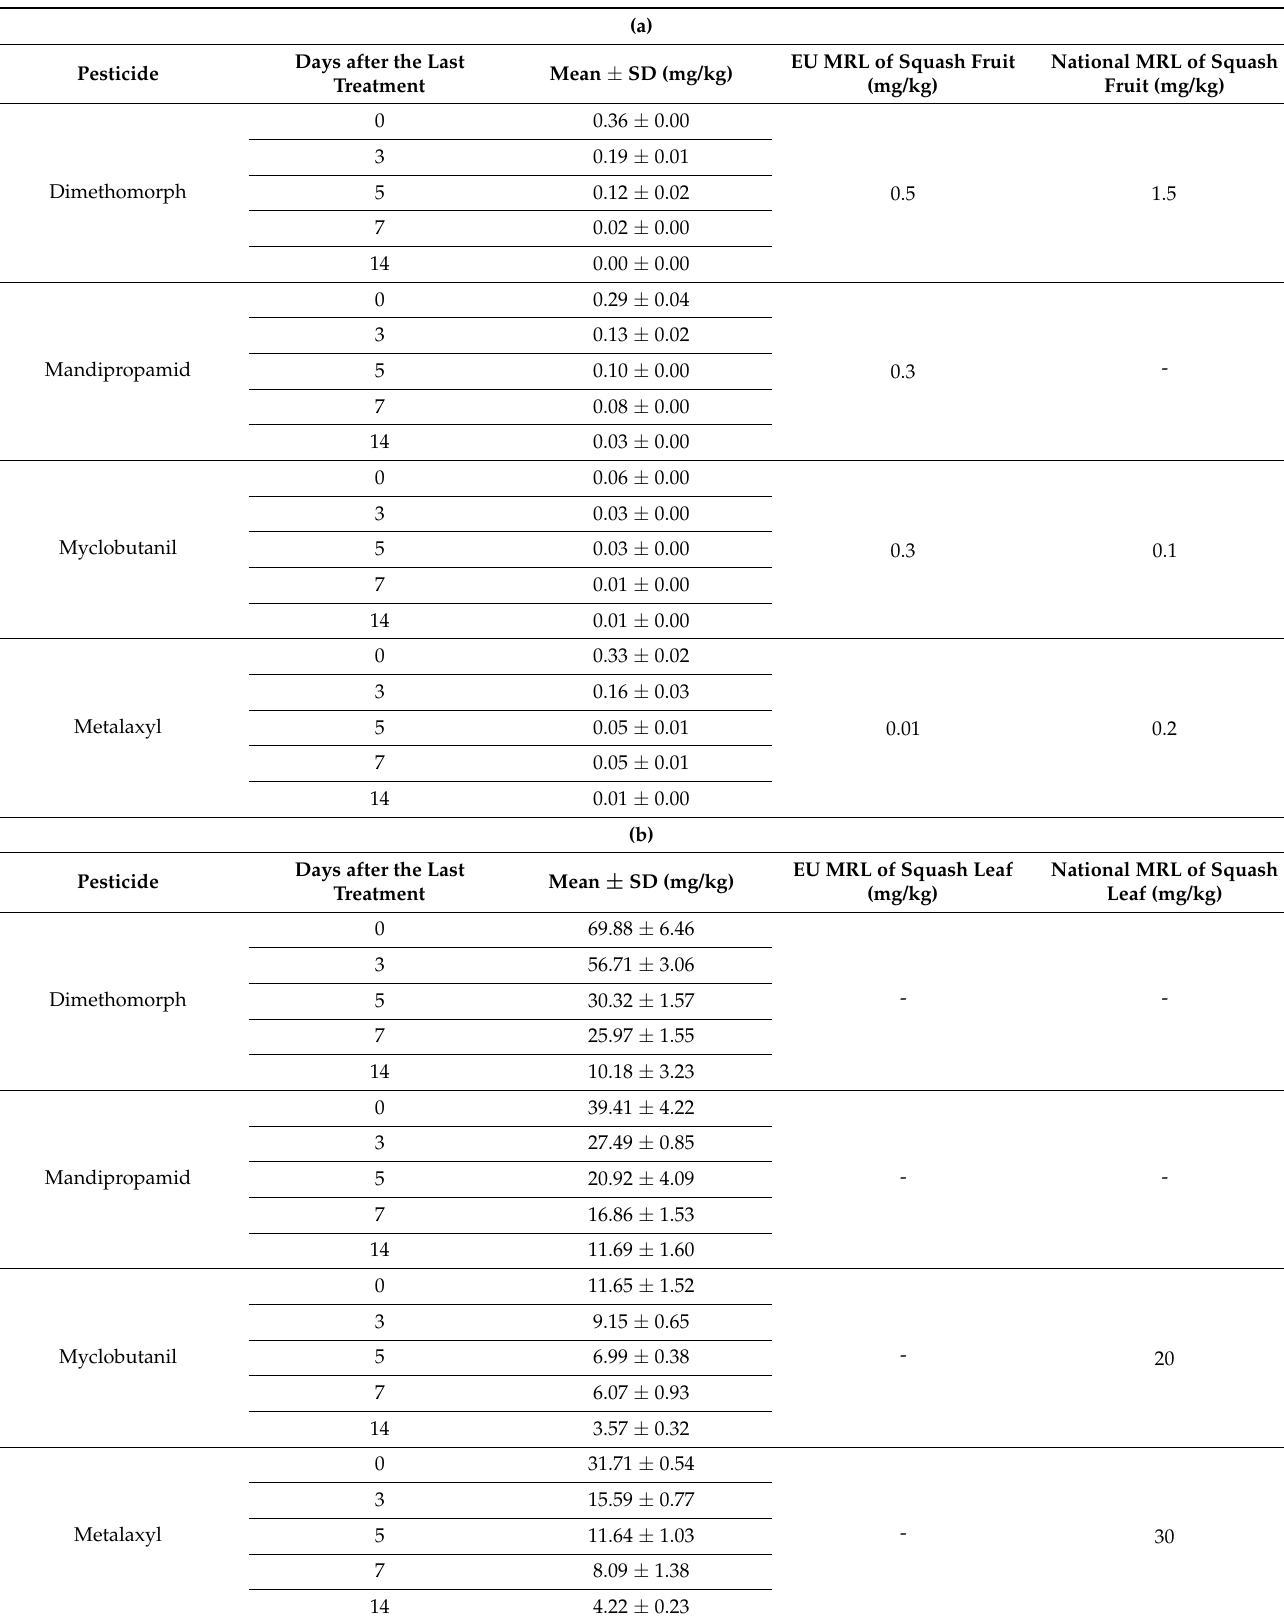
Table 4. ( a ) Average residues of four pesticides in squash fruit. ( b ) Average residues of four pesticides in squash